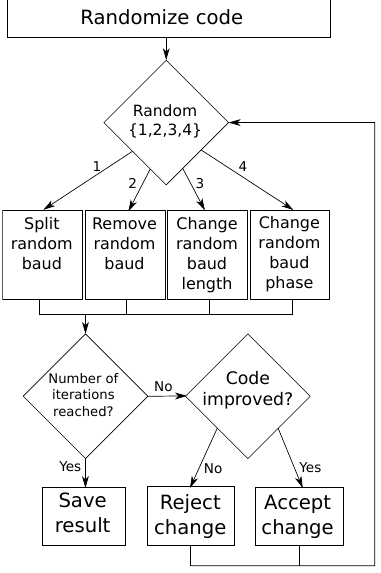
Fig. 3. Simplified block diagram of the optimization algorithm.